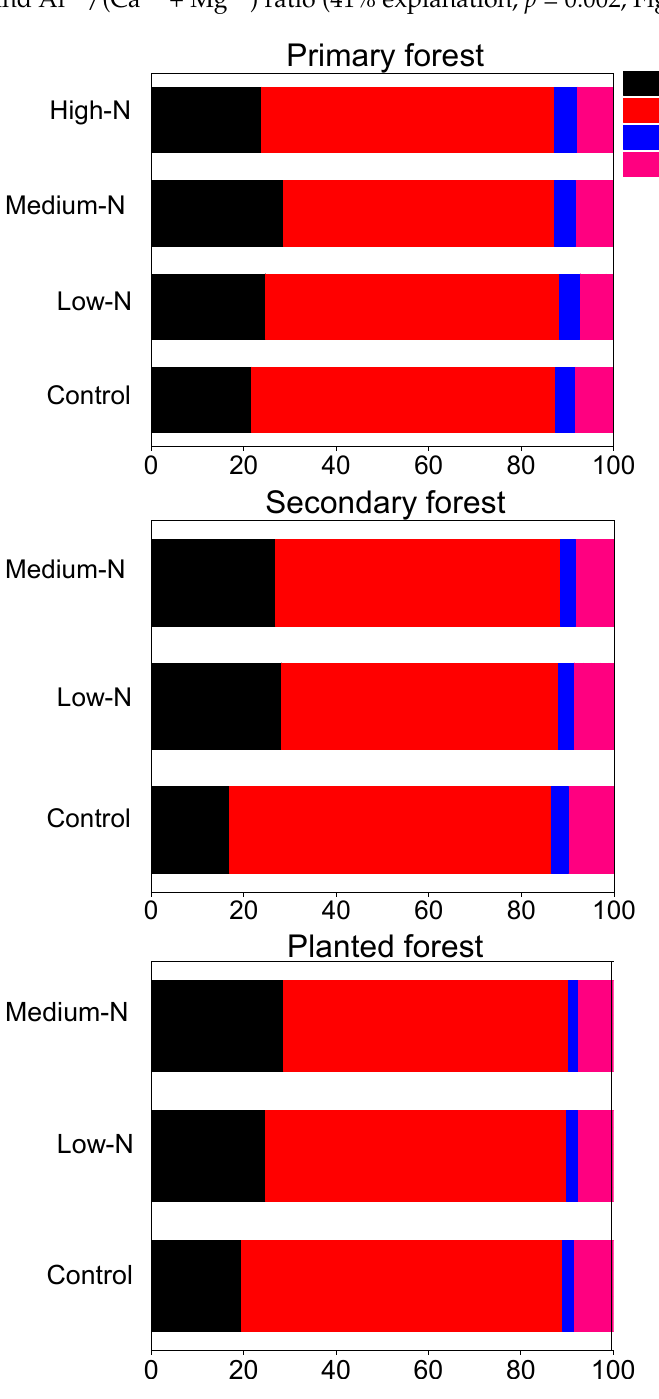
Figure 6. Effects of 8 years of N addition on the relative proportion (%) of soil exchangeable H + , Al 3+ , and Fe 3+ and base cations (at an equivalent basis; sum of K + , Ca 2+ , Na + , Mg 2+ ) at 0–10 cm mineral soils in the primary forest, the secondary forest, and the planted forest in southern